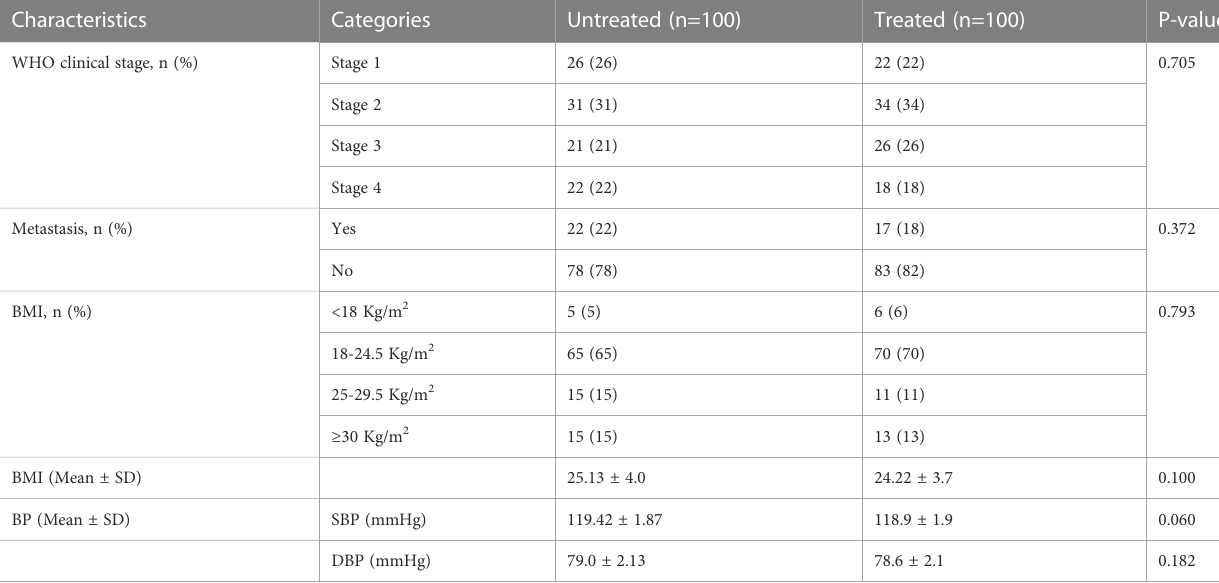
TABLE 2 Clinical characteristics of AC-treated and untreated BC